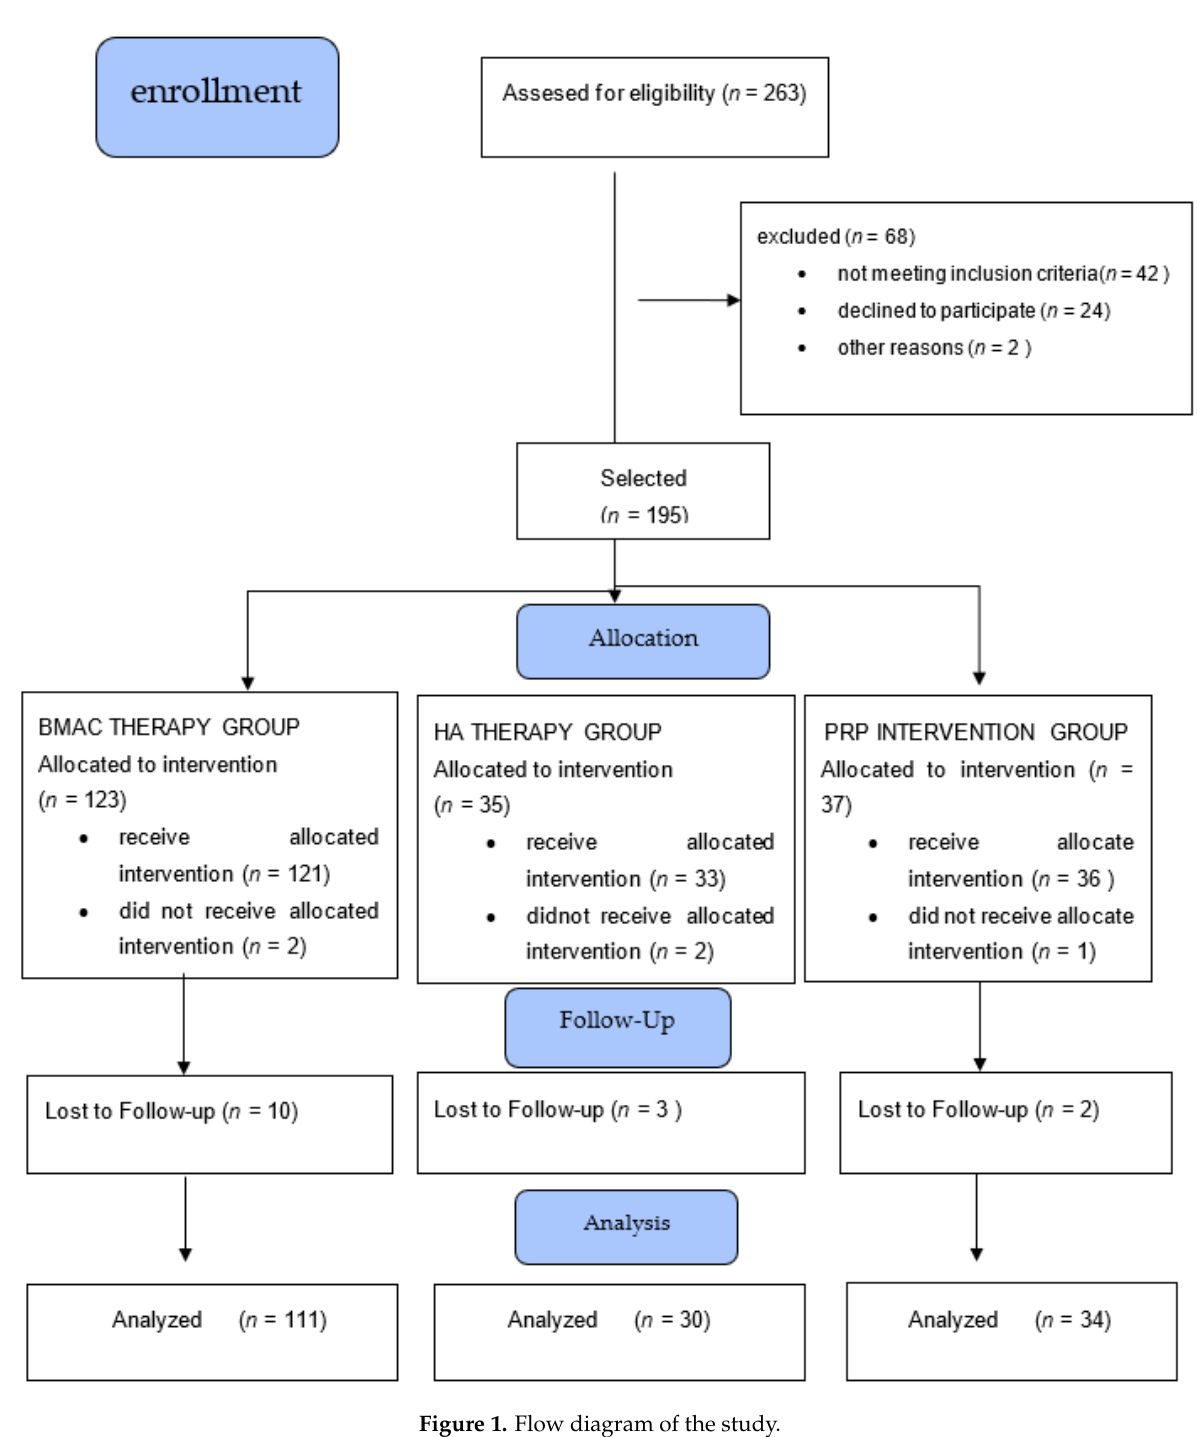
Figure 1. Flow diagram of the study.